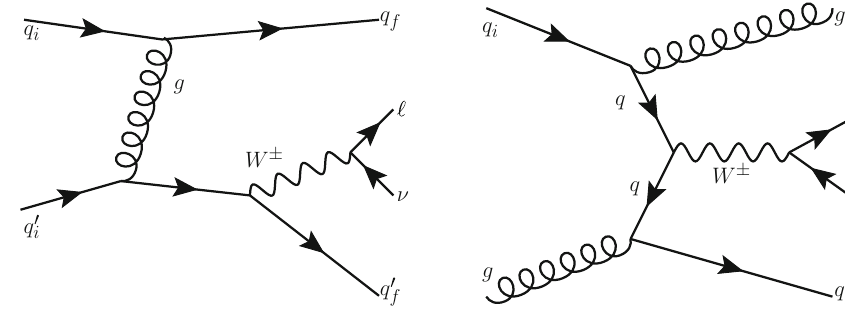
W ± boson radiation by any incoming or outgoing quark, and two c non-resonant diagrams, corresponding to W ± boson radiation by either incoming quark